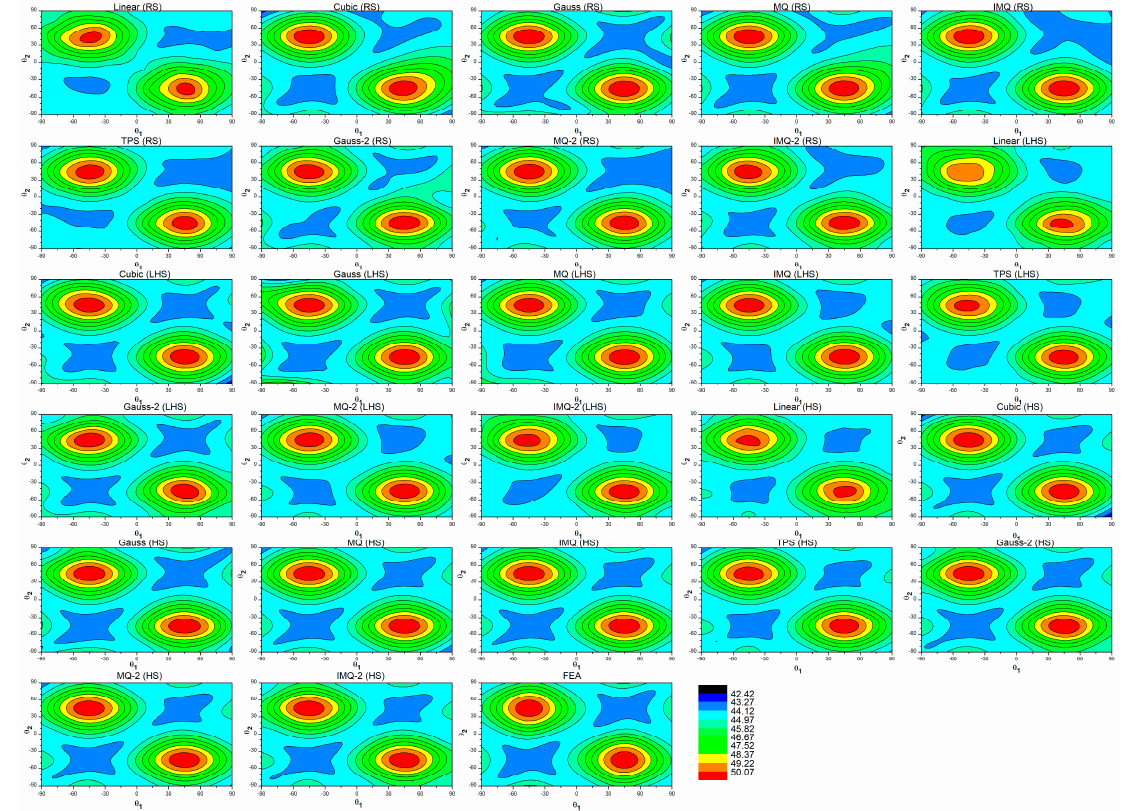
Figure A2. 2D contour plots for first frequency of the LD problem generated by various RBF metamodels.